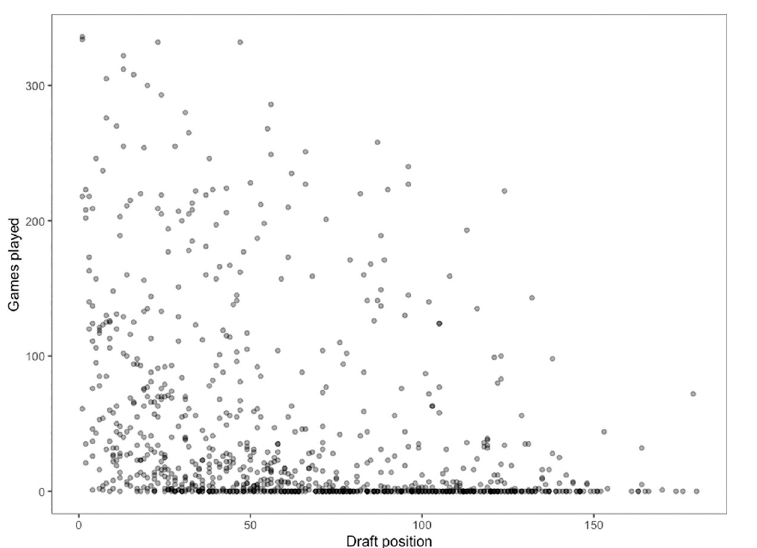
Fig 1. Relationship between draft selection order and matches